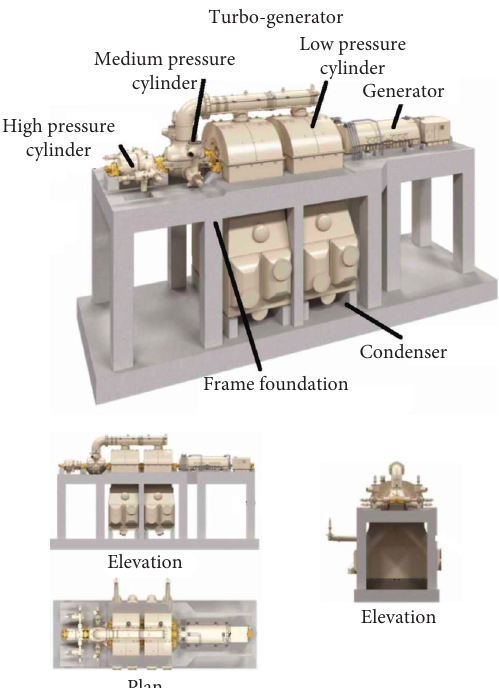
Figure 2: Concrete foundations for turbine generators (HP-IP-LP- LP with bottom